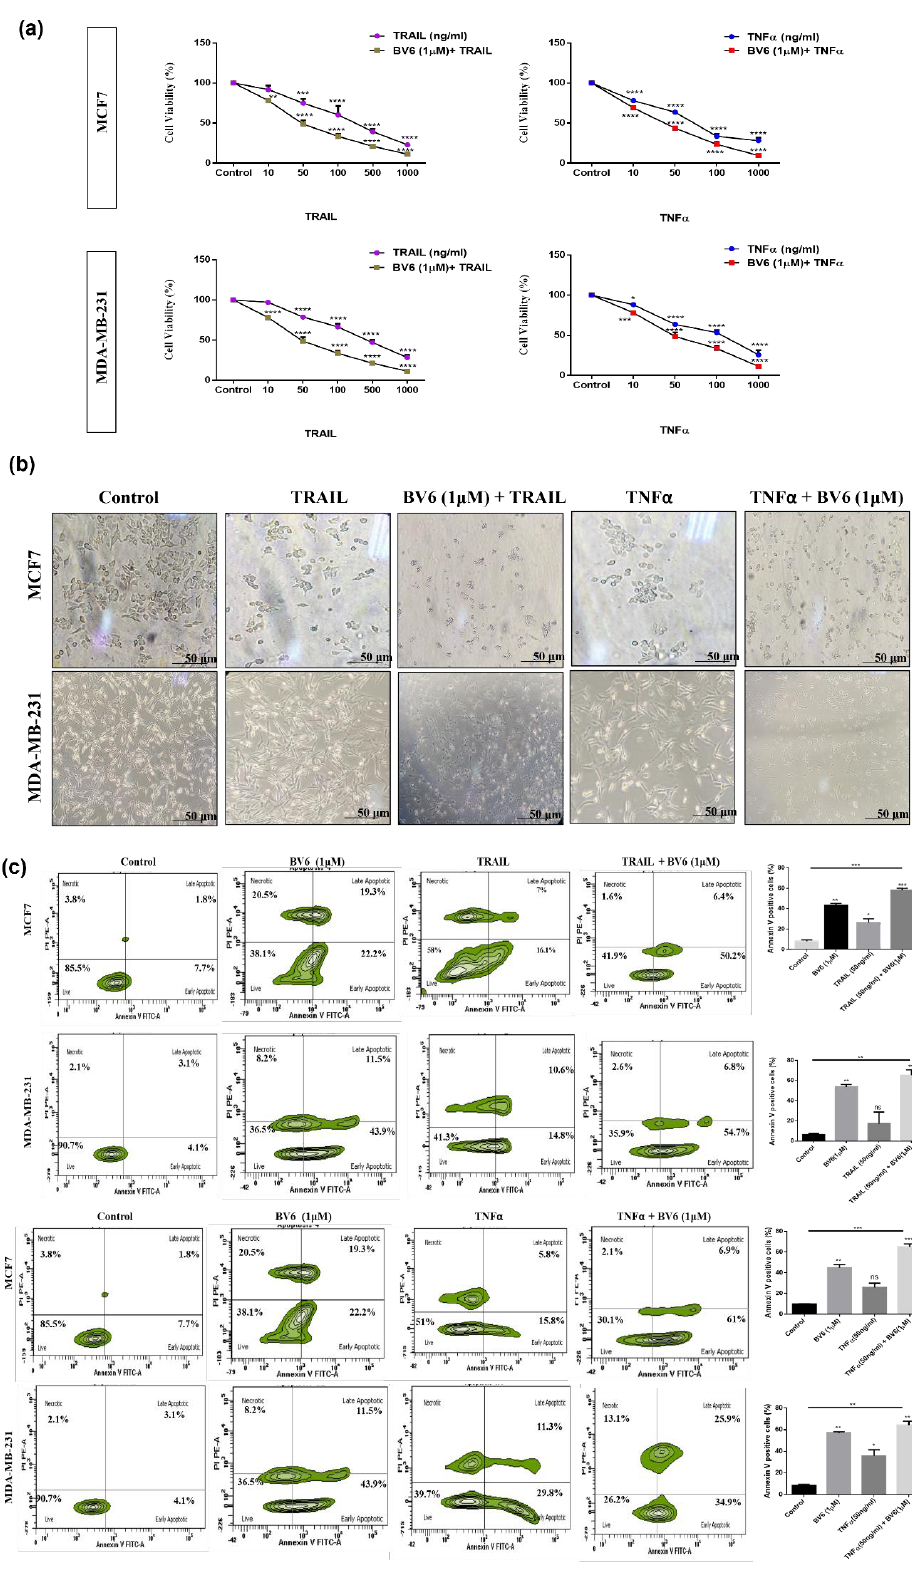
Figure 5. ( a ) Effect of TRAIL, TNF α and their combination with BV6 on MCF7 and MDA-MB-231 cells by MTT assay: Treatment of cancer cells was done with an increasing concentration of TRAIL, TNF α alone and in combination with 1 µ M of BV6 for 24 h. ( b ) Effect of TRAIL (50 ng/mL), TNF α (50 ng/mL) and their combination with BV6 (1 µ M) on MCF7 and MDA-MB-231 cells